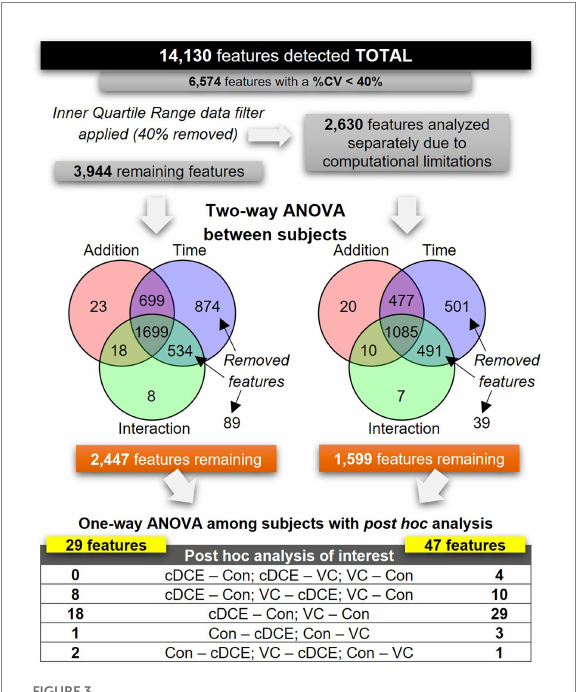
FIGURE 3 Flowchart outlining data analysis steps for all detected